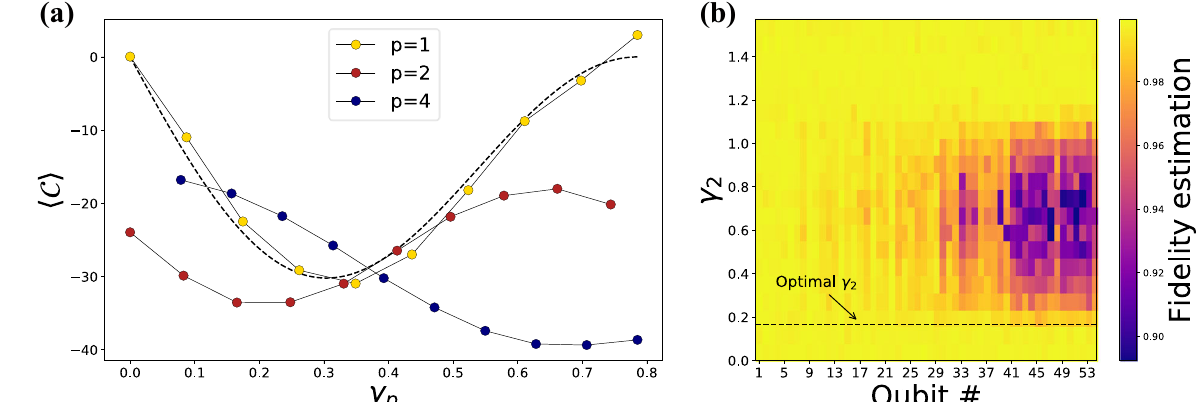
Fig. 4 Simulating 54 qubits. a Randomly generated 3-regular graphs with 54 nodes are considered at p = 1, 2, 4. At each p , all angles were set to optimal values (except for the fi nal γ p ) for a smaller graph of 20 nodes for which optimal angles can be found at a much smaller computational cost. Cost dependence along this 1D slice of the variational landscape (a higher-dimensional analogue of panel a of Fig. 2) is investigated. The dashed line represents the exact cost at p = 1. Error bars were too small to be visible on the plot. At p = 2, this 54-qubit simulation approximately implements 162 RZZ gates and 108 RX gates while at p = 4 there are 324 RZZ s and 216 RX s. b An array of fi nal stochastic estimations of single-qubit fi delities (see Sec. Approximate gate application for formula) in the course of optimizer progress. The system presented consists of 54 qubits at p = 2 where exact state vectors are intractable for direct comparison. In these simulations, β 1 , β 2 , and γ β β γ fi delity estimates begin γ 1 are kept at their optimal values. Optimal 2 value (for given 1 , 2 , 1 ) is shown with a dashed line. We note that the to drop approximately as γ 2 increases beyond the optimal value. A similar qubit-by-qubit trend can be noticed across all system sizes and depths p we